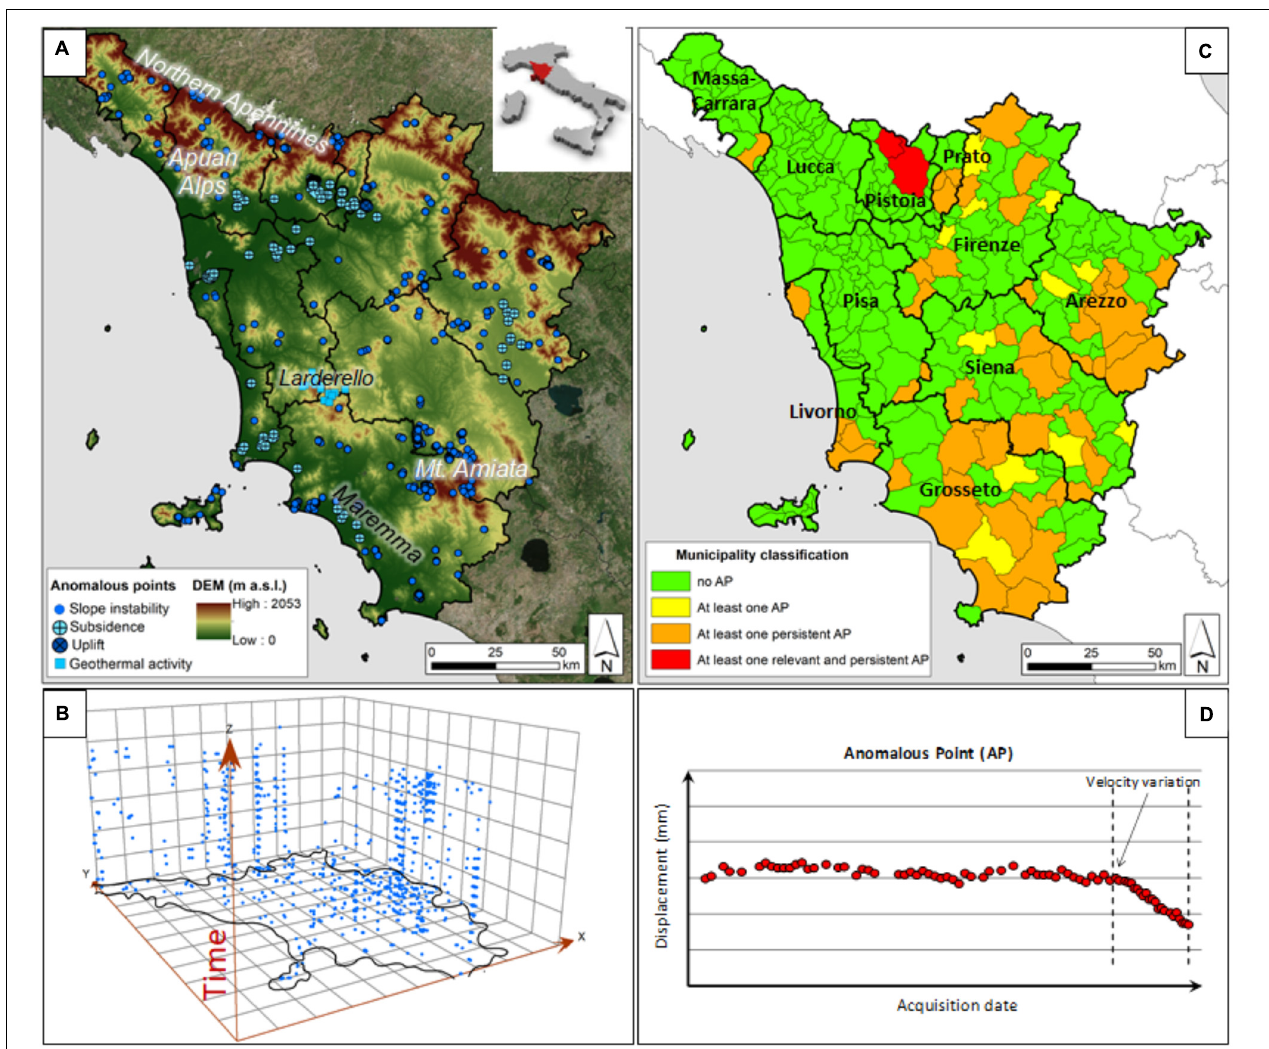
FIGURE 2 | (A) Spatial distribution of the main Anomalous Points (APs) recorded in the Tuscany Region; (B) space-time cube graph of Aps; (C) weekly bulletin that contains a municipality classification of traffic light like color-codes with respect to the increasing attention level depending on the presence of Aps (modified after Raspini et al., 2018. We have obtained the copyright permissions to reproduce the already published figure); (D) persistent scatterers temporal series of an